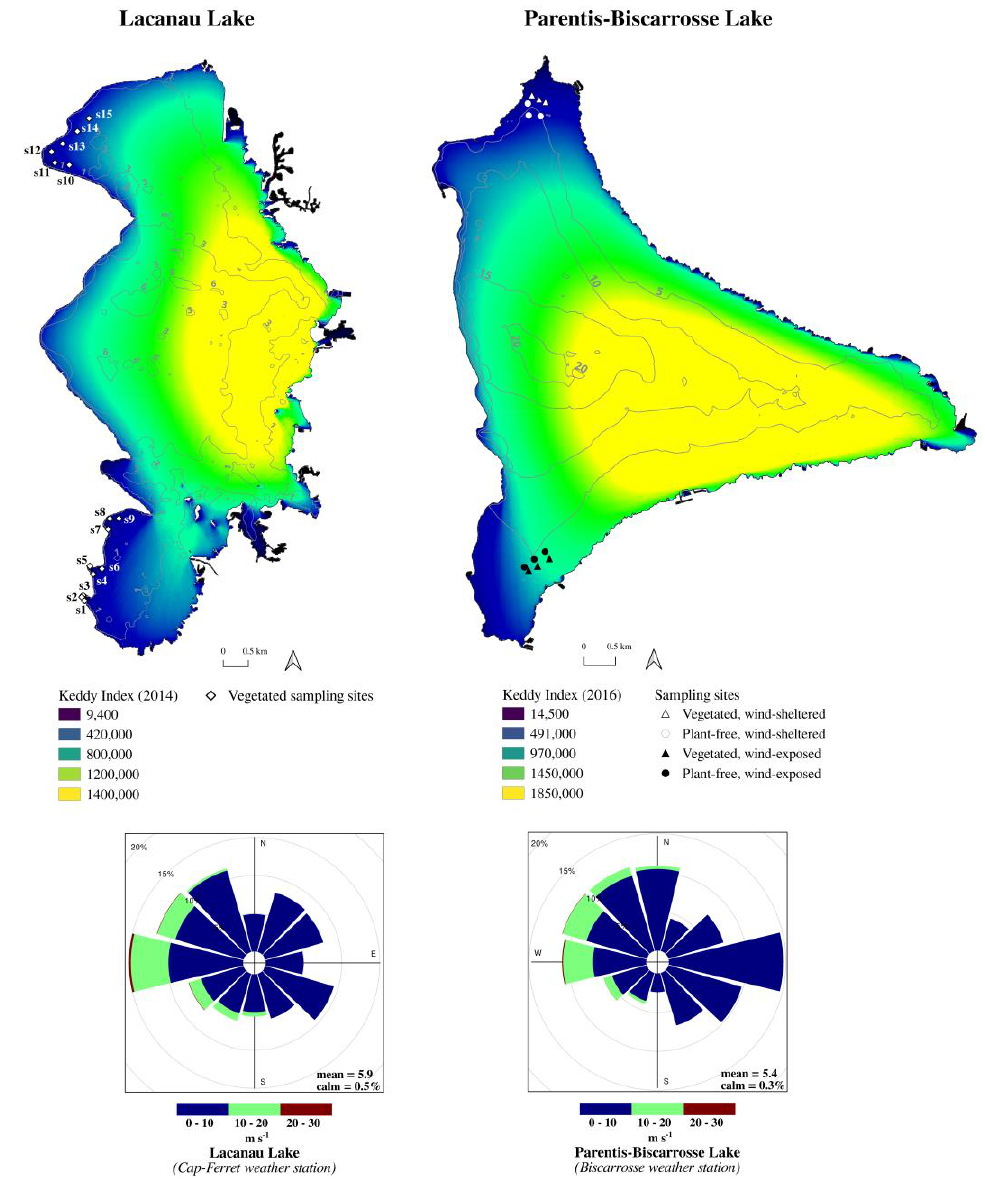
Figure 1. Keddy Index calculated on annual basis for Lacanau Lake (on the left ) and Parentis-Biscarrosse Lake (on the right ). The windrose is calculated on wind speed and direction hourly data on an annual basis. Lake bathymetry and sampling sites for seasonal 24-cycle campaigns (LAC Lake), as well as sampling sites for seasonal campaigns at wind-sheltered and -exposed sites (PAR Lake) are reported.